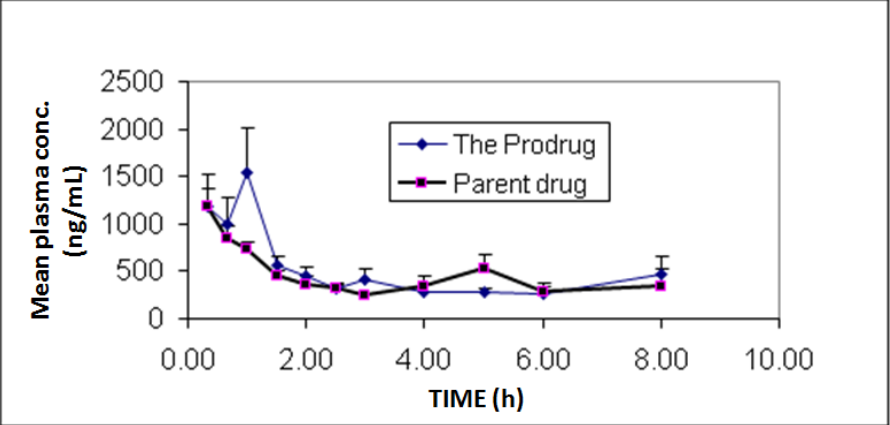
Figure 3. Mean plasma concentrations profile of diclofenac sodium ( 1 ) and diclofenac produced from the hydrolysis of the N -ethoxycarbonylmorpholine ester prodrug ( 2 ). Values are mean ± SEM from 6 rabbits.